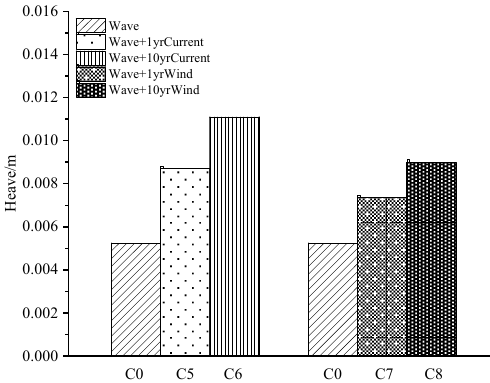
Figure 23. RMS for heave responses.